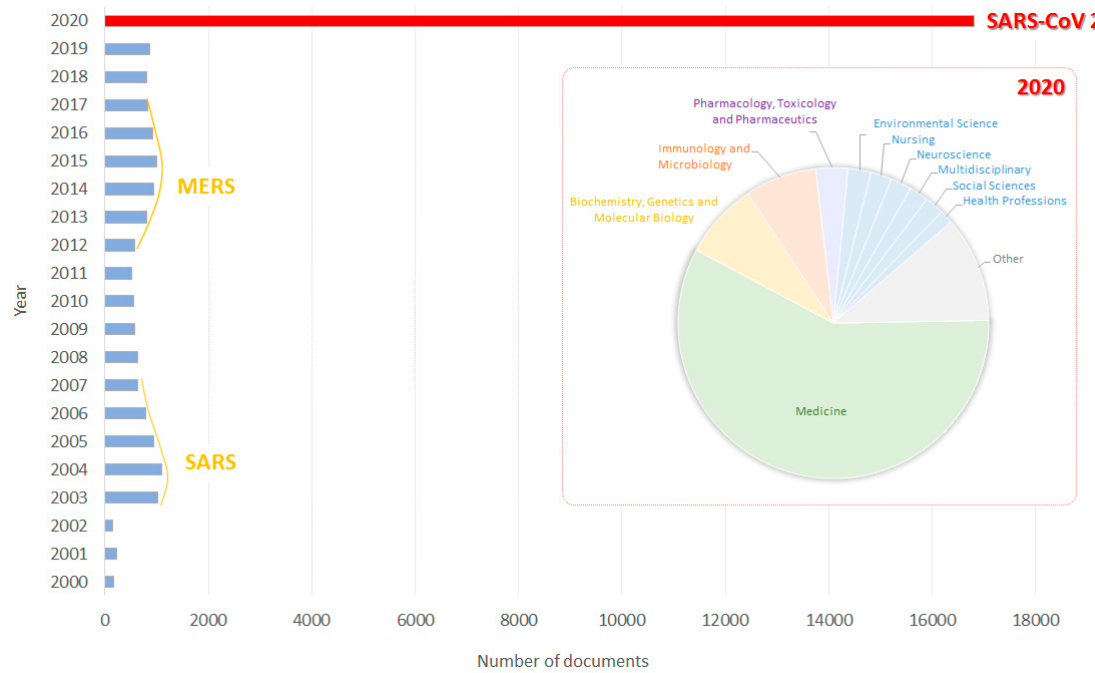
Figure 1. Number of documents per year dealing with the word “coronavirus.” In the red box documents by subject area published in 2020 (source Scopus Database, accessed on 1 July 2020).